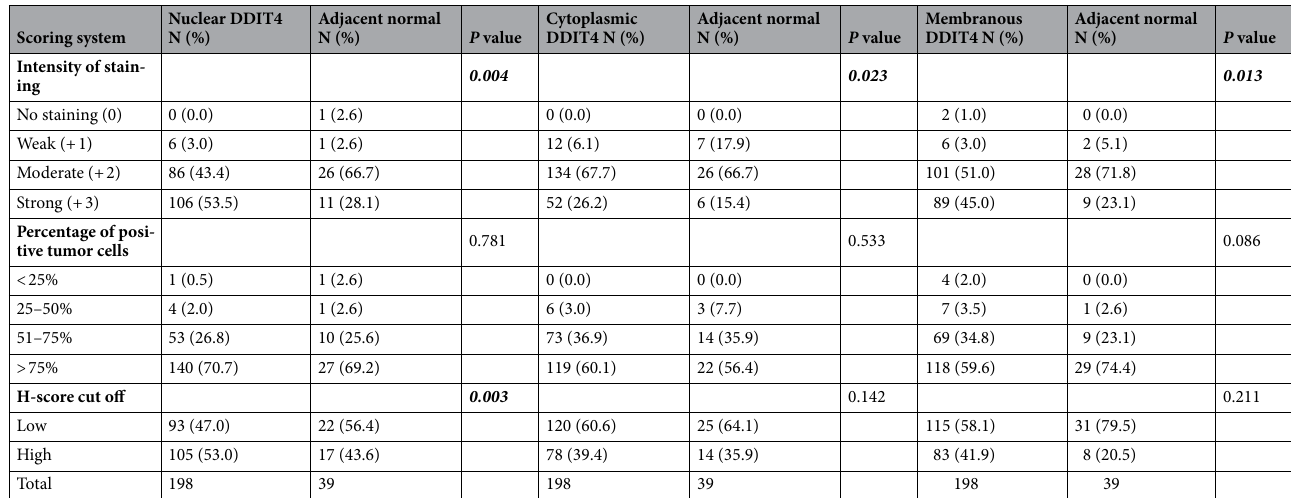
Table 2. Nuclear, cytoplasmic, and membranous DDIT4 expression in colorectal cancer (CRC) tissues and their adjacent normal tissue samples (Intensity of staining, percentage of positive tumor cells, and H-score). P value is based on Mann–Whitney U test. H-score histological